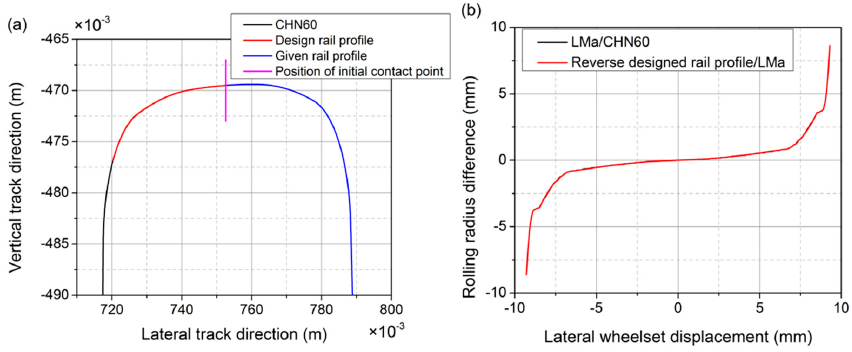
Figure 10. Reverse designed wheel profile and rolling radius difference. ( a ) Comparison between reverse designed profile and CHN60 profile; ( b ) Comparison between rolling radius differences.